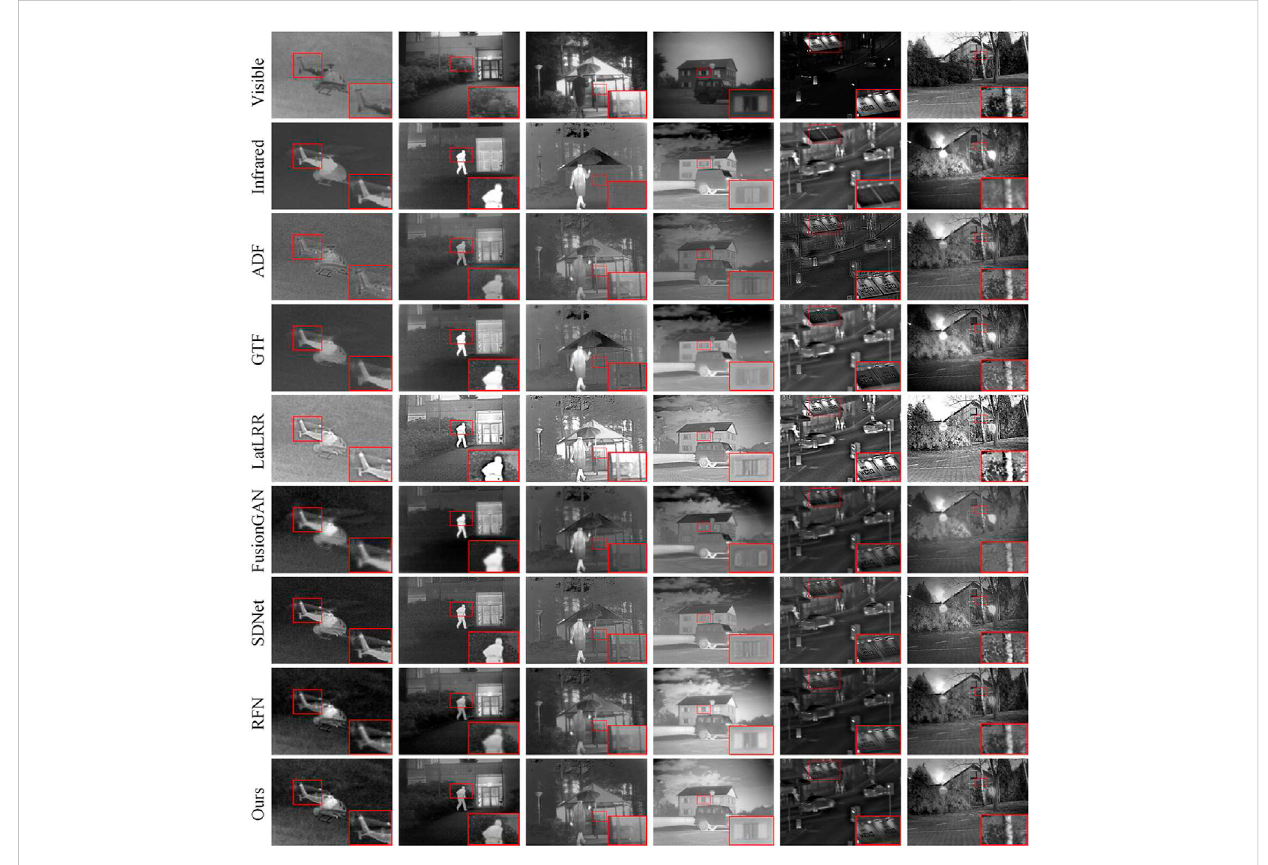
FIGURE 5 Fusion results of different methods on six pairs of images from TNO and VOT2020-RGBT datasets.